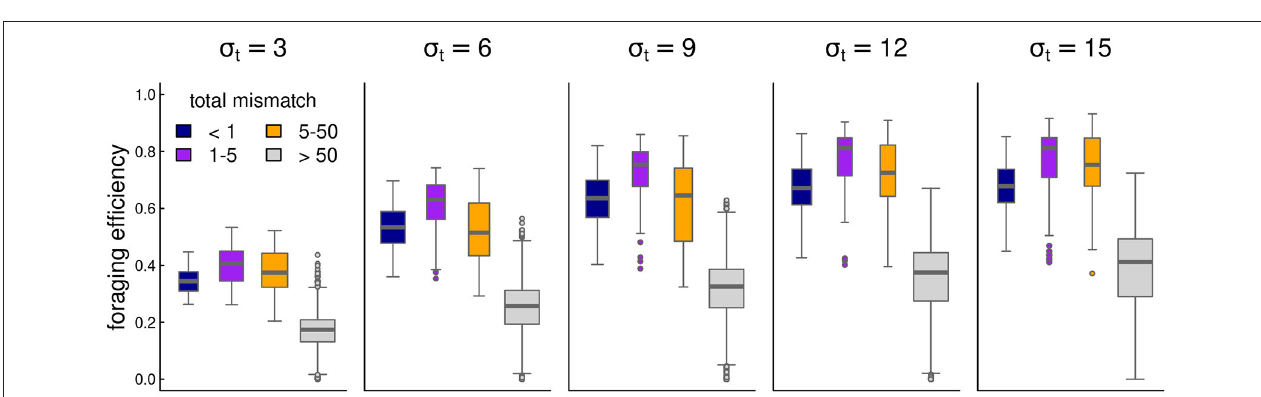
FIGURE 4 | Box-plots of foraging efficiency against mismatch across several values of foraging patch duration.